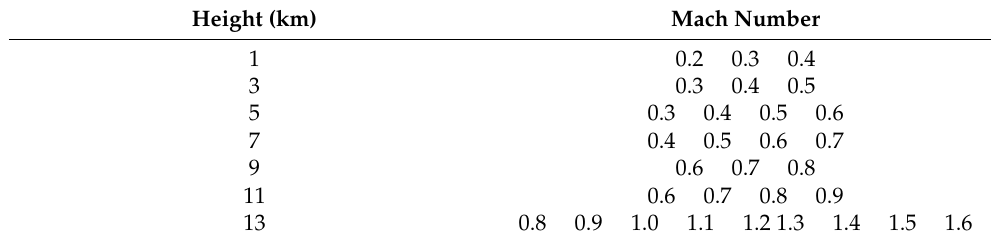
Table 3. Calculation status points in the recovery stage.